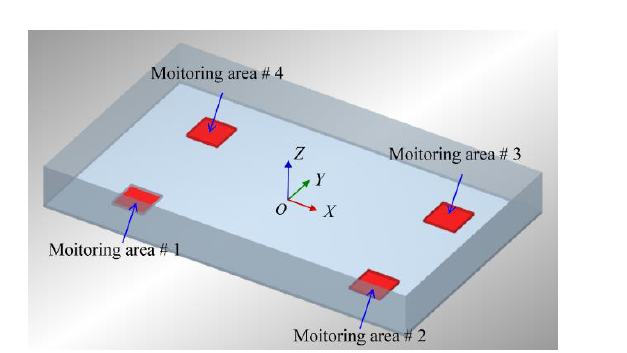
Figure 1. Schematic diagram of seed tray model.